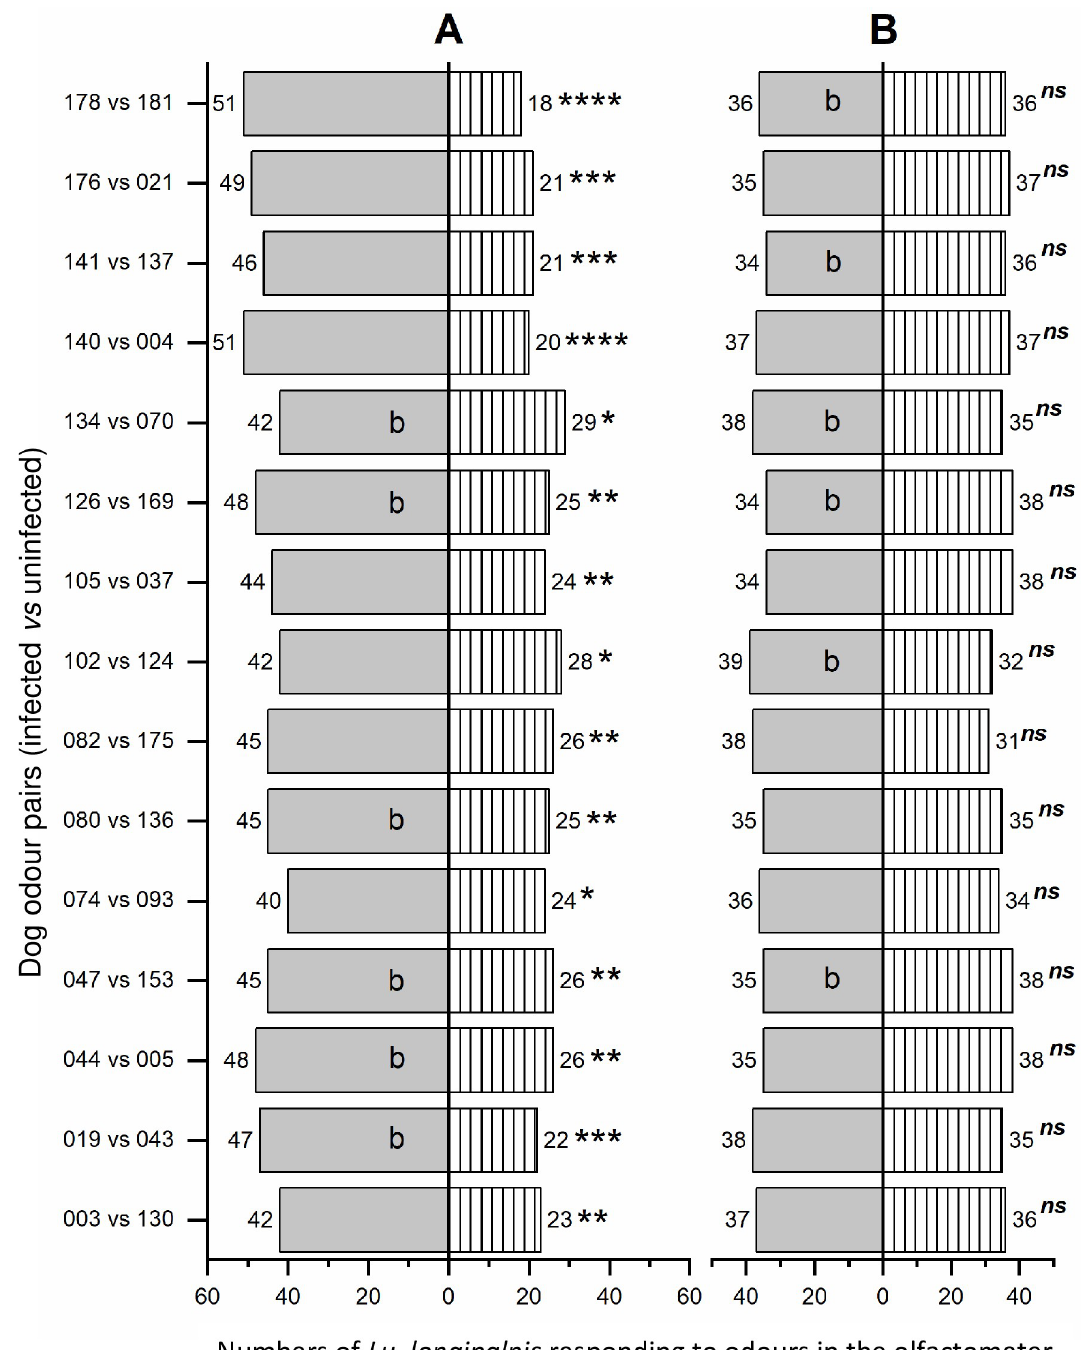
Fig 1. Numbers of female (A) and male (B) Lutzomyia longipalpis attracted to volatiles collected from infected and uninfected dogs. https://doi.org/10.1371/journal.ppat.1009354.g001 The numbers of female (panel A) or male (panel B) Lu . longipalpis attracted to the infected dog odour (grey bars) or uninfected dog odour (hatched bars) in the Y-tube olfactometer. The dog odour pairs are indicated on the y-axis, the first in each pair is from an infected dog and